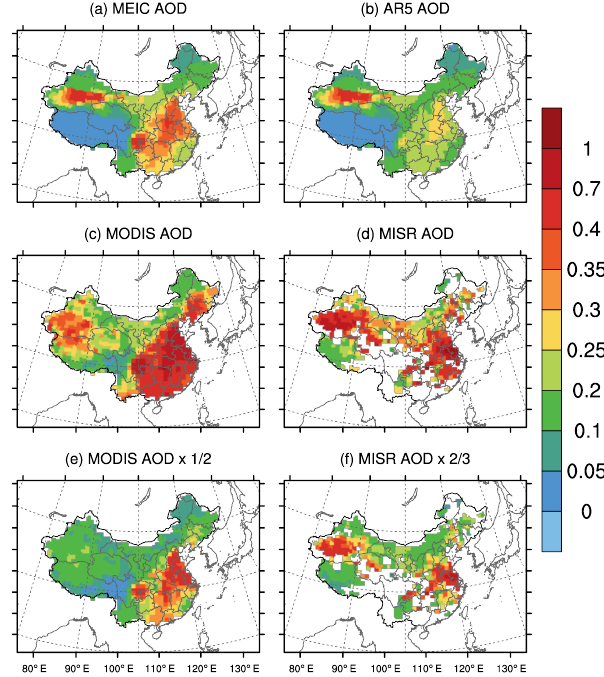
Figure 3. Spatial distributions of annual-average AOD at 550nm over China in 2009 simulated by CAM5-MAM3 using (a) the MEIC emission and (b) the AR5 emission, observed by (c) MODIS and (d) MISR satellites, (e) MODIS AOD scaled by one-half, and (f) MISR AOD scaled by two-thirds. The scaling factors are approxi- mately the ratios between the modeled AOD with the MEIC emis- sion and retrieved AODs averaged over eastern